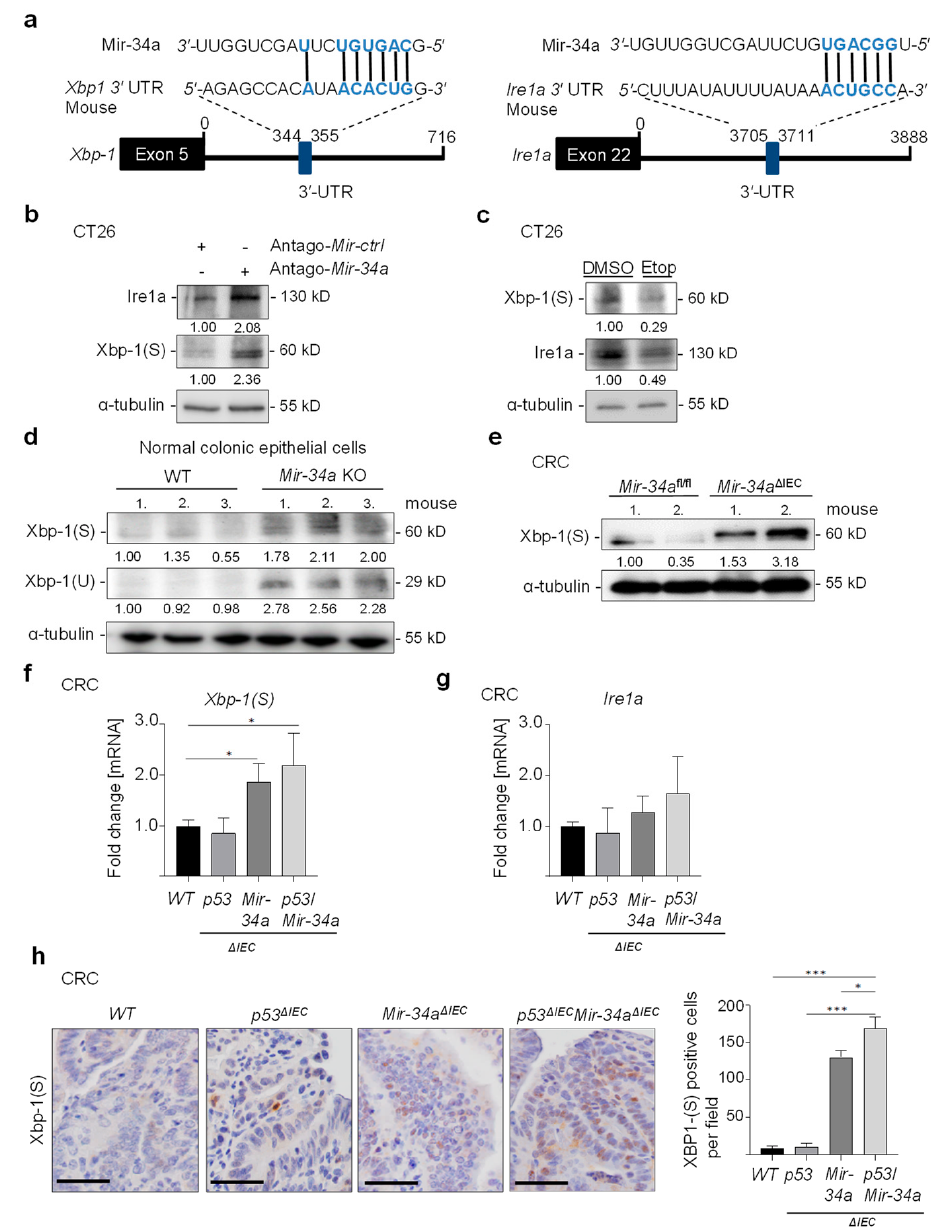
Figure 4. Xbp-1(S)/Ire1a expression in Mir-34 a-deficient mice. ( a ) Schematic representation of the murine Xbp-1 and Ire1a 3 ′ -UTRs indicating the miR-34a seed matching sequences (SMS). The black vertical bars indicate possible base pairing. ( b ) Western blot analysis of Xbp-1(S) and Ire1a in CT26 cells transfected with antago-Mir-34a or antago-miR negative control oligonucleotides for 48 h. ( c ) Western blot analysis of Xbp-1(S) and Ire1a in CT26 cells after addition of etoposide (20 µ M) for 48 h. ( d ) Western blot analysis of Xbp-1(S) and Xbp-1(U) in lysates prepared from